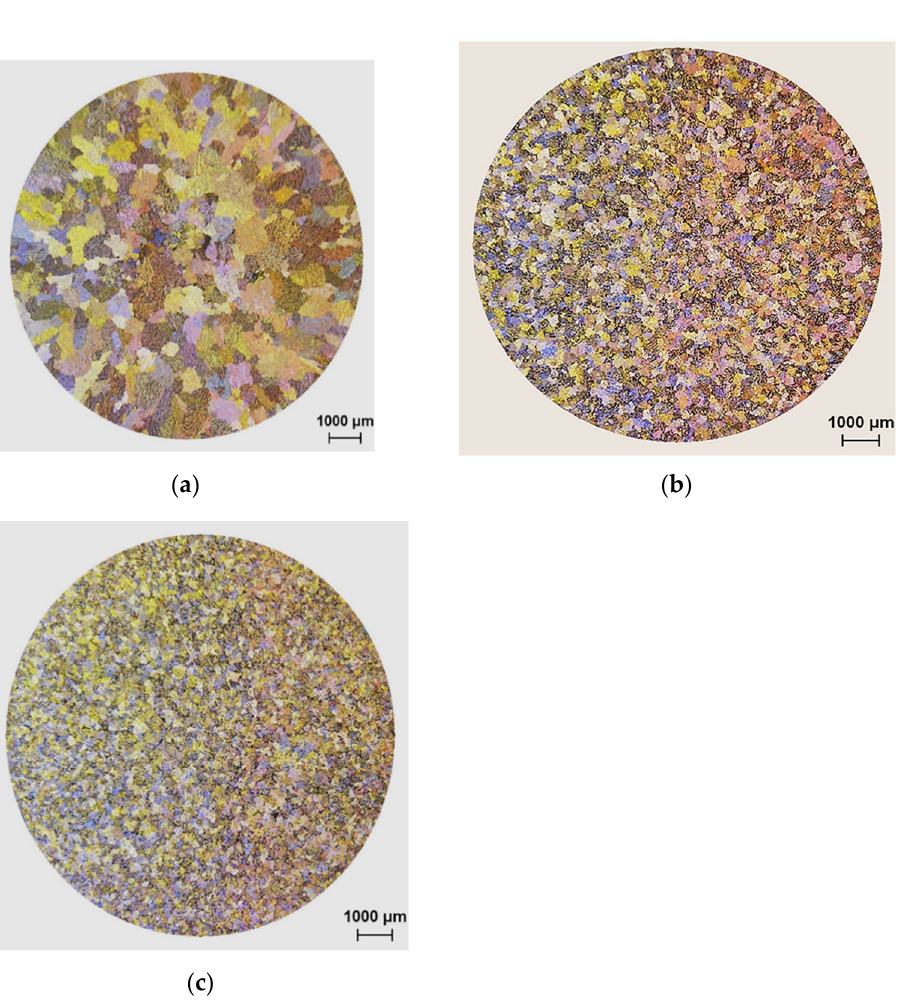
Figure 3. Optical macrographs and average grain sizes of the as-cast microstructure in the ( a ) 220A, ( b ) 220L and ( c ) 220M alloys.